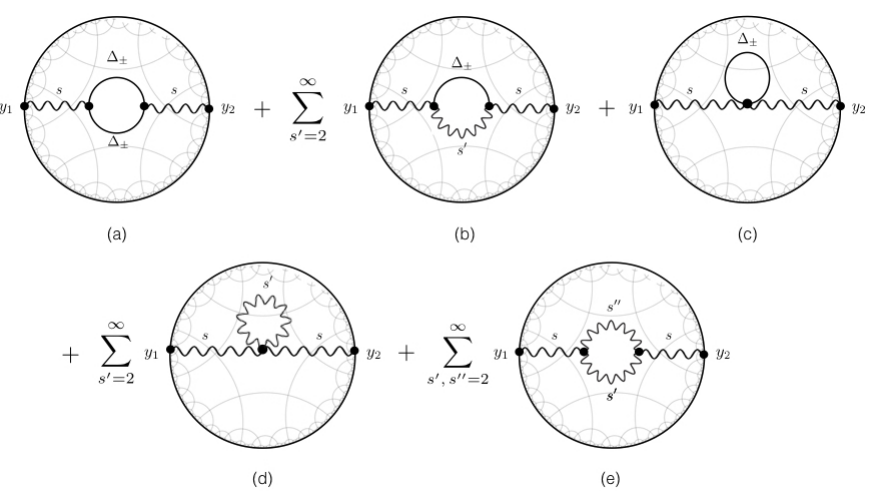
Figure 12. Diagrams contributing to the one-loop two-point amplitude M (cid:1) (cid:6) ; total 1-loop s ( y 1 ; y 2 ) with external spin- s gauge (cid:12)elds in the type A higher-spin gauge theory on AdS 4 , for both the (cid:1) + and (cid:1) (cid:0) boundary conditions on the bulk scalar. Diagrams (a) and (b) were considered in section 4.2 of this